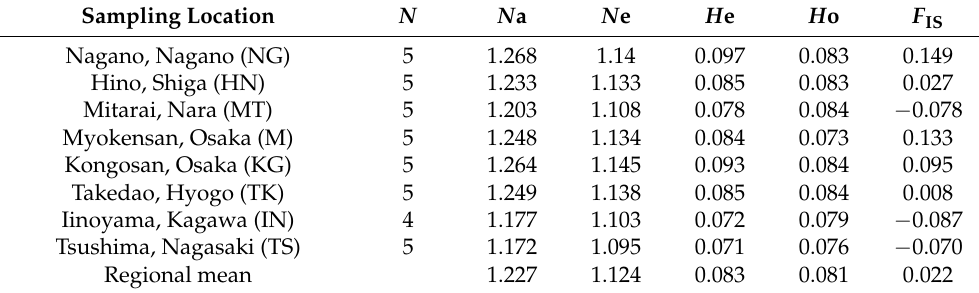
Table 4. Genetic diversity parameters of the eight populations of Lindera obtusiloba (Lauraceae) in Japan based on 688 SNP loci. Letters in parentheses are abbreviations of sampling